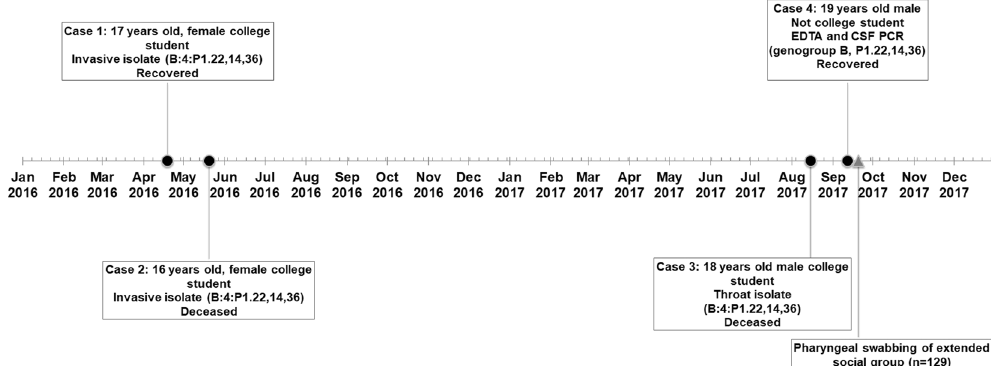
Figure 1. A timeline illustrating the timing and details of four adolescent cases during a MenB meningococcal outbreak in Bristol in 2016 and 2017. Two cases occurred in college students in early 2016 and a further two cases occurred in late 2017. A pharyngeal swabbing exercise was performed among an extended social group shortly after case